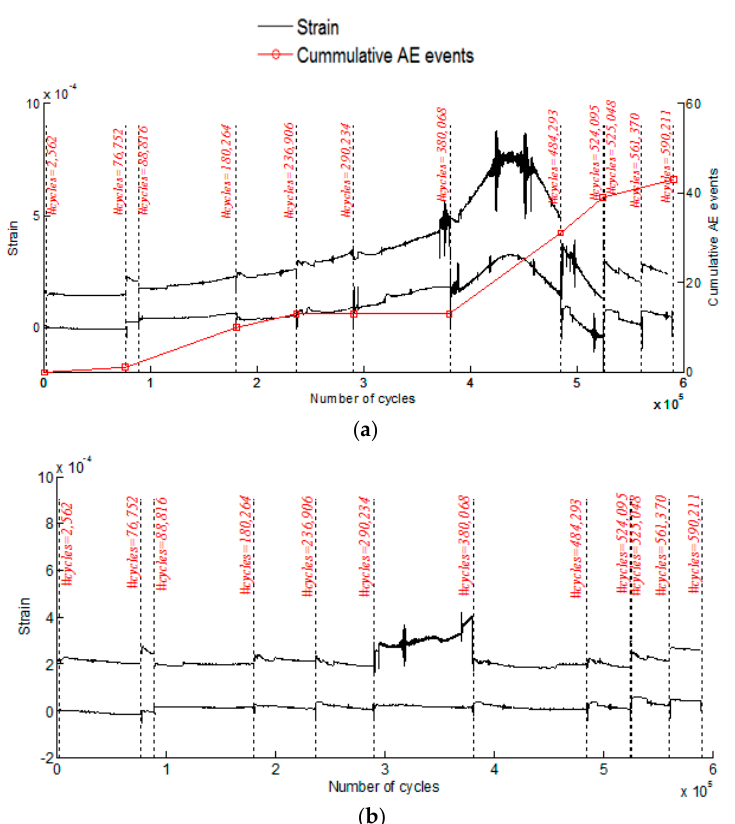
Figure 8. The strain history versus cumulative AE events; ( a ) strain gauge 1; and ( b ) strain gauge 2.